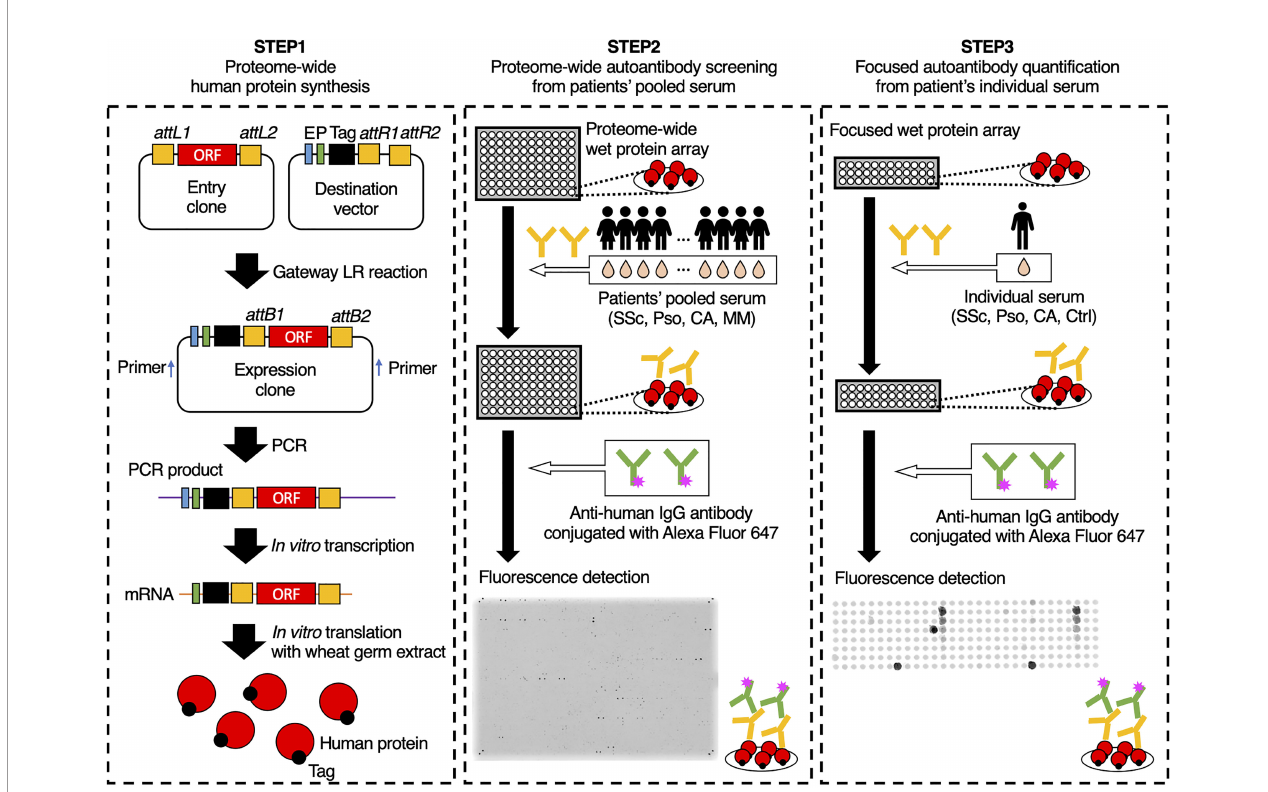
FIGURE 1 | Schematic of the autoantibody screening pipeline. In the fi rst step, proteins were synthesized in vitro from the proteome-wide human cDNA library (HuPEX). Promotors (P), Enhancers (E), and FLAG-GST tags were fused to open reading frames of the expression clones by Gateway LR reaction. After polymerase chain reaction ampli fi cation and in vitro transcription, translation was performed using the wheat germ cell-free synthesis system. In the second step, we conducted autoantibody screening by treating proteome-wide wet protein arrays with pooled serum. In the third step, autoantibody quanti fi cation was performed by treating focused wet protein arrays with individual sera. ORF, open reading frame; SSc, systemic sclerosis; Pso, psoriasis; CA, cutaneous arteritis; MM, malignant melanoma; Ctrl, healthy